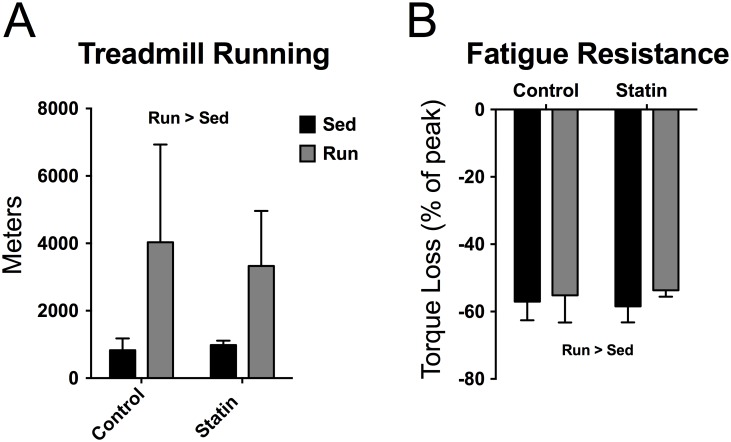
The effects of exercise training and simvastatin treatment on treadmill running capacity and contractile fatigue resistance (n = 7–8 per exercise/treatment group).A: Distance run during a progressive velocity treadmill running test to exhaustion. Run > Sed indicates main effect of training, P < 0.001. B: Plantarflexor torque loss following a fatiguing bout of 120 contractions. Run > Sed indicates main effect of training, P < 0.040. Torque loss is expressed as a percent of the peak torque generated during the protocol.